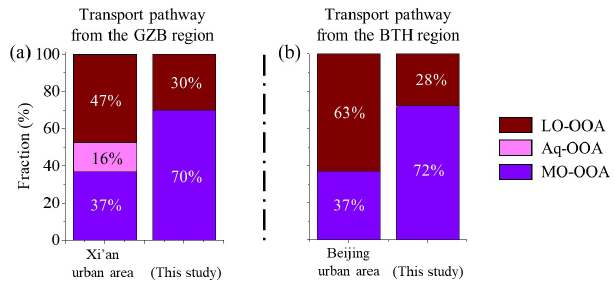
Figure 8. The relationship between production of the secondary organic aerosol and transport duration in the pollution episodes. EP1 and EP2 represented the pollution episodes caused by the BTH transport and the urban GZB transport,